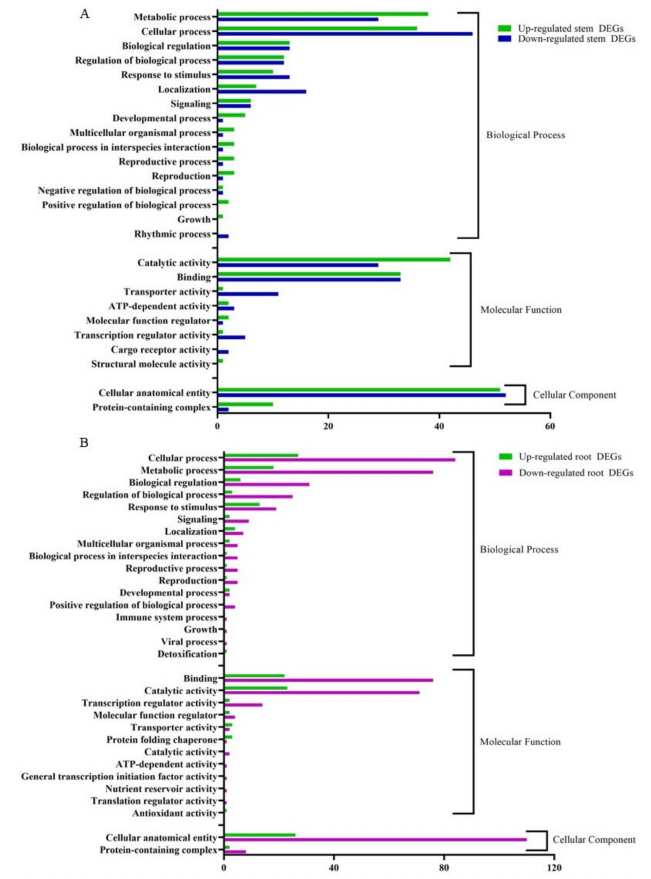
Figure 6. Clusters of orthologous groups functional classification of differentially expressed genes (DEGs), between non-infected and citrus dwarfing viroid (CDVd)-infected ( A ) stem and ( B ) root tissues. The bar graph shows the number of sequences and distribution in different functional categories of the predicted targets at gene ontology (GO) level